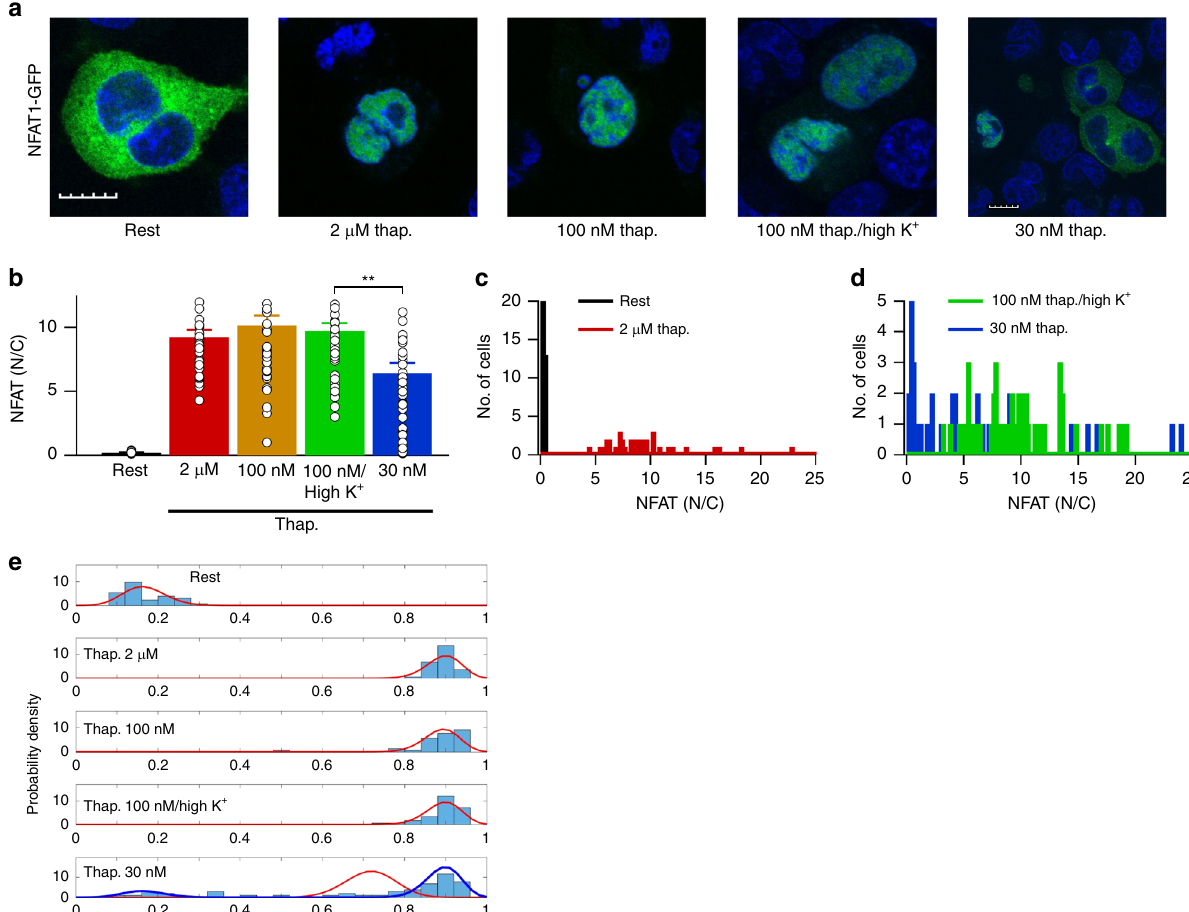
Fig. 3 Effect of different concentrations of thapsigargin on NFAT1 nuclear accumulation. a Confocal images compare NFAT1-GFP distribution between cytosol and nucleus for the conditions shown. Cells were stimulated for 40 min. Whole scale bar is 10 μ m. Nuclei were stained with DAPI (blue). b Aggregate data from experiments as in panel a are compared. Each bar is > 30 cells. c Histogram compares nuclear accumulation between resting (non- stimulated) cells and cells challenged with 2 μ M thapsigargin. d Histogram compares NFAT1-GFP distribution between cells challenged with 30 nM thapsigargin in standard K + solution and 100 nM thapsigargin in high K + solution. e Binomial distributions of nuclear/cytosolic NFAT1-GFP are derived from data as in panels c and d . The red trace for 30 nM thapsigargin (representing the data) could be deconstructed into two distributions (blue), re fl ecting non-responders and responders. **denotes p < 0.01, determined using unpaired Student ’ s t -test. Error bars denote FACS analysis of c-fos and NFAT-reporter gene expression . In a third approach, we compared c-fos and NFAT1 expression in the same cells using fl uorescence-activated cell sorting (FACS). We co-transfected YFP (under a c-fos promoter) and RFP (under an NFAT promoter). Little expression of either protein occurred under resting conditions (Fig. 5a), when compared with non- transfected cells (labelled Blank in Fig. 5a). The histograms in Fig. 5b, c show YFP and RFP expression, respectively, for the conditions indicated. Stimulation with 30 nM thapsigargin evoked little increase in YFP expression compared with resting cells (Fig. 5a, b) but caused a signi fi cant increase in RFP levels (Fig. 5a, c). Stimulation with 100 nM thapsigargin in high K + solution also failed to increase c-fos expression (Fig. 5a, b) but led to signi fi cantly more expression of RFP than seen with 30 nM thapsigargin (Fig. 5a, c). The median fl uorescence value from all cells that exhibited a fl uorescence intensity value > 10 3 , a value seen in the blank group. Compared with non-stimulated resting cells, stimulation with 30 nM thapsigargin or 100 nM thapsi-